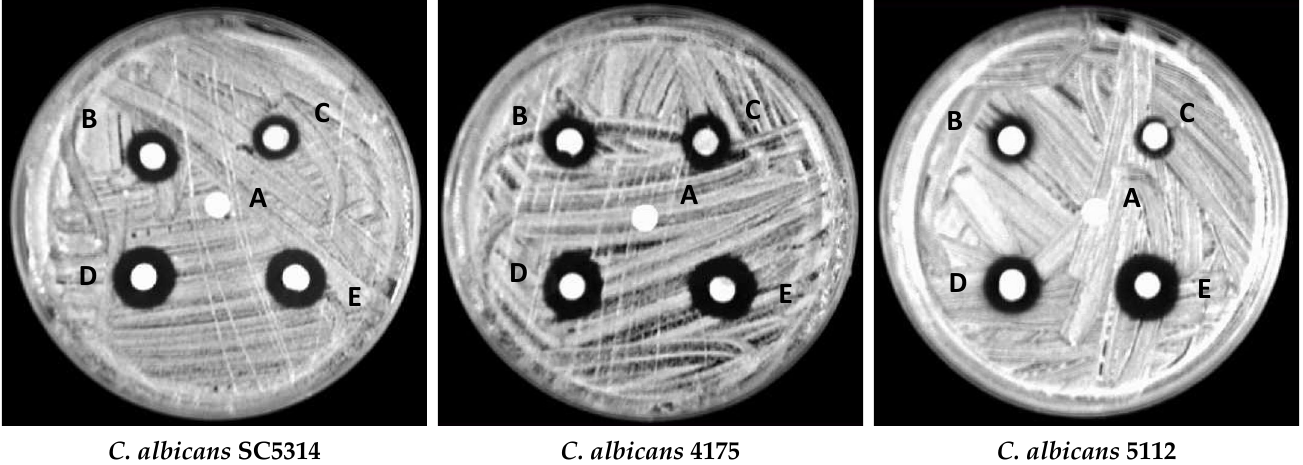
Figure 13. Representative images of zones of inhibition around discs impregnated with 1% DMSO ( A ), 2 µ g/mL ampho- tericin B ( B ), ½ MIC of ZnONPs ( C ), MIC of ZnONPs ( D ), and MFC of ZnONPs ( E ) against different Candida albicans isolates. Table 4. Zones of inhibition (mm) induced by bio-synthesized ZnONPs against different C. albicans isolates. Concentration of ZnONPs